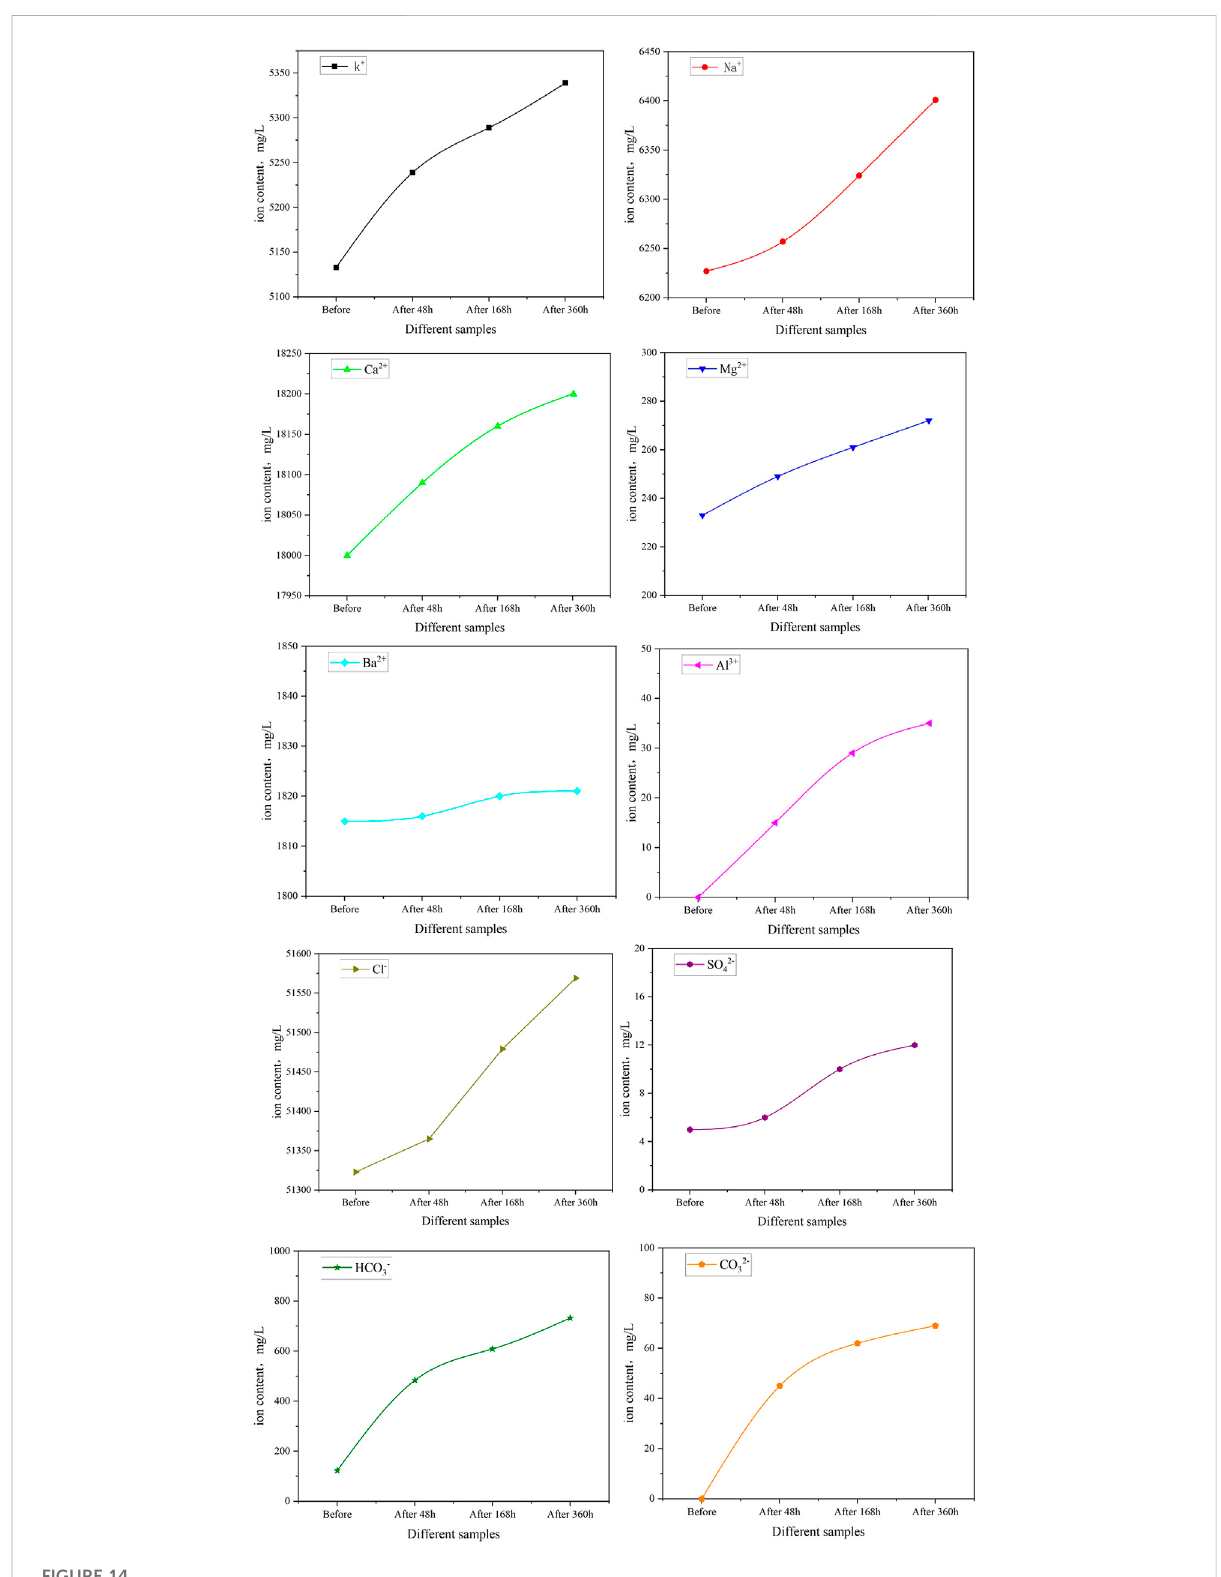
FIGURE 14 Change of mineral composition of after different action time of sandstone and supercritical CO 2